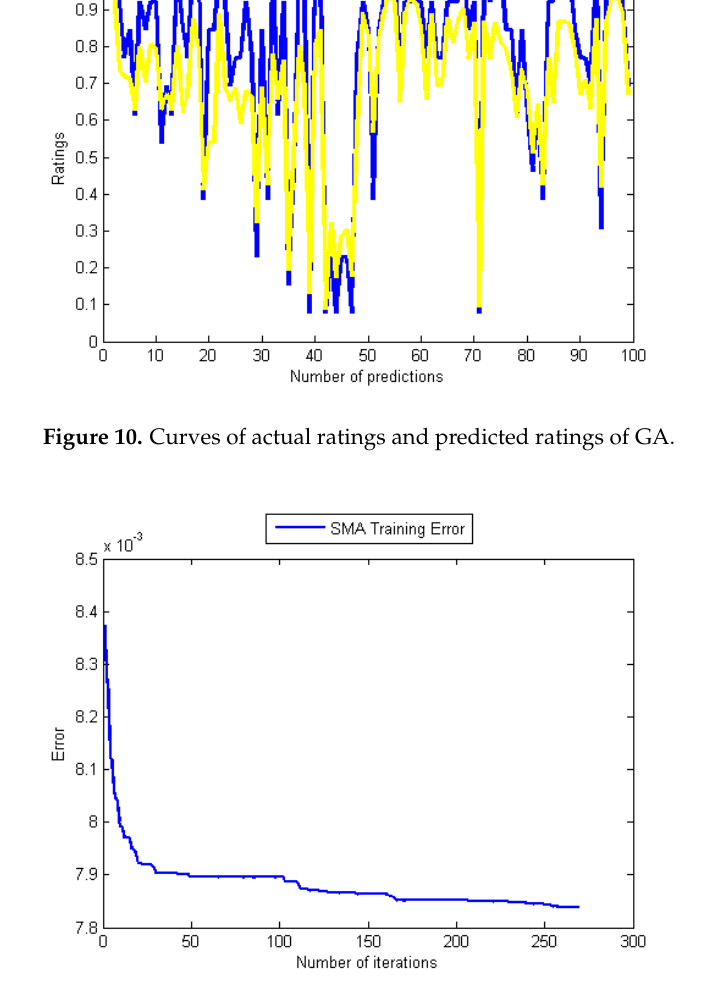
Figure 11. Error Performance measure during training with the